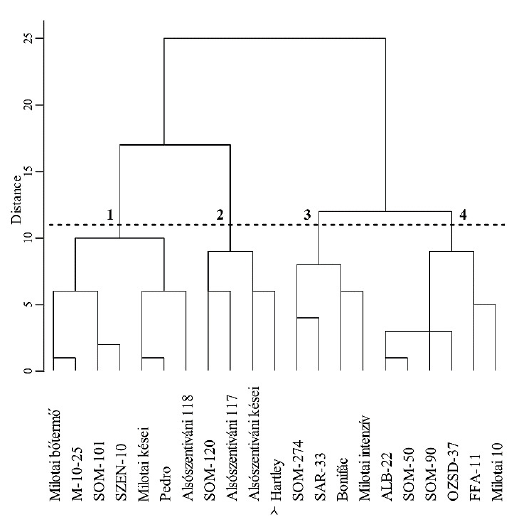
Fig. 3. Dendogram based on the average linkage (between groups) method of cluster analysis by means of necrotic spot diameter and disease rate of the walnut blight infection for walnut cultivars (2010– 2013) Numbers on the dendogram indicate different groups: 1: moderate resistant (mR), 2: moderate susceptible (mS), 3: susceptible (S), 4: highly susceptible